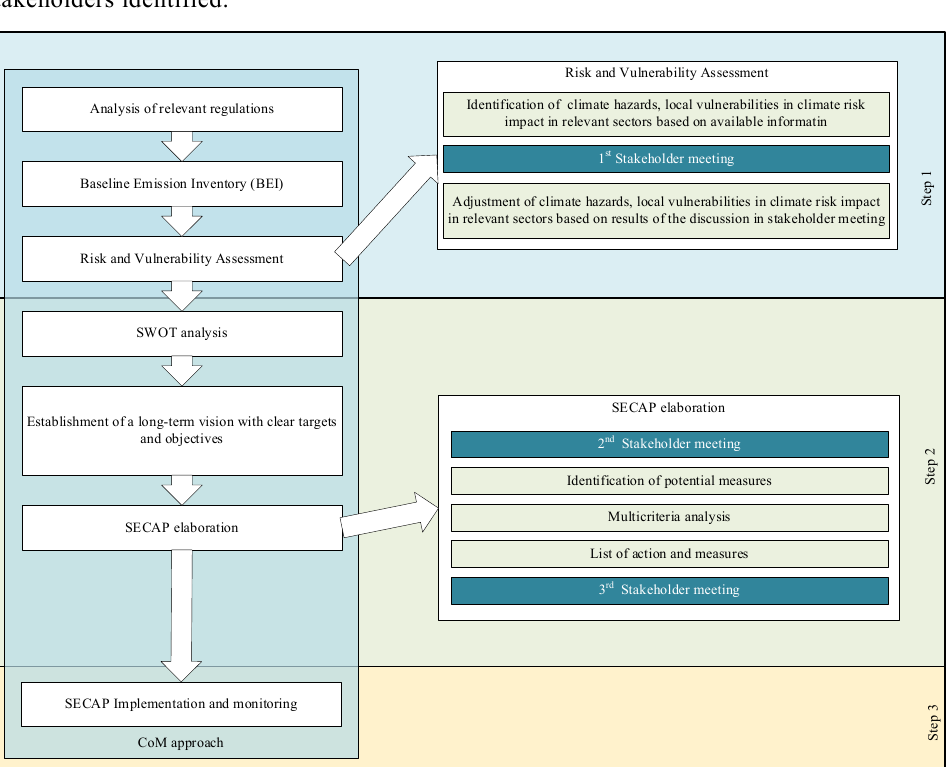
Fig. 1. CoM approach and proposed key steps for preparing a SECAP [26],